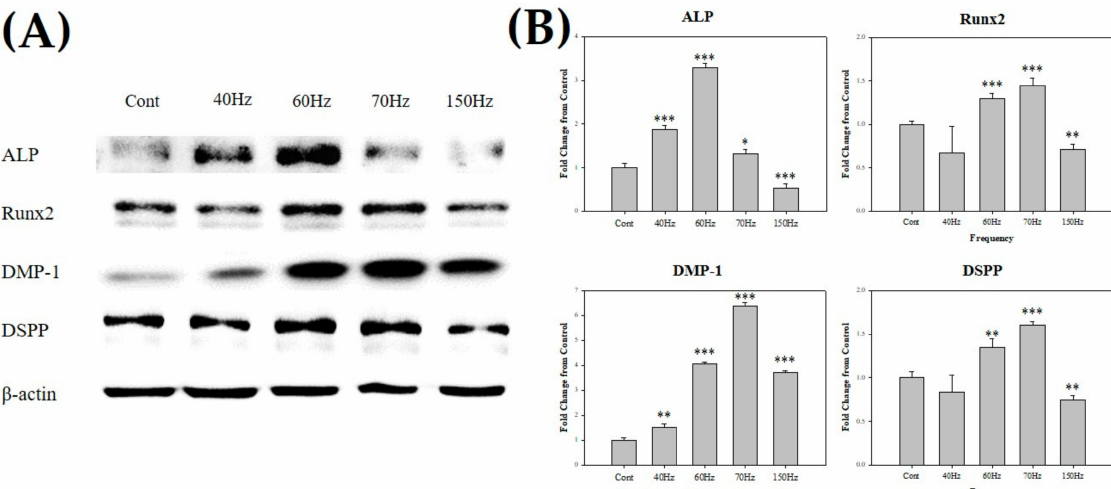
Figure 4. ( A ) Western blot of ALP, Runx2, DMP-1, DSPP, and β -actin after exposure to 10 mT PEMF for 3 days. ( B ) All markers were increased in the cells exposed to PEMF. Each target protein was normalized to β -actin. Notably, most markers were expressed at 60 and 70 Hz. * p < 0.05, ** p < 0.01, *** p < 0.005 (compared with the control). ALP;